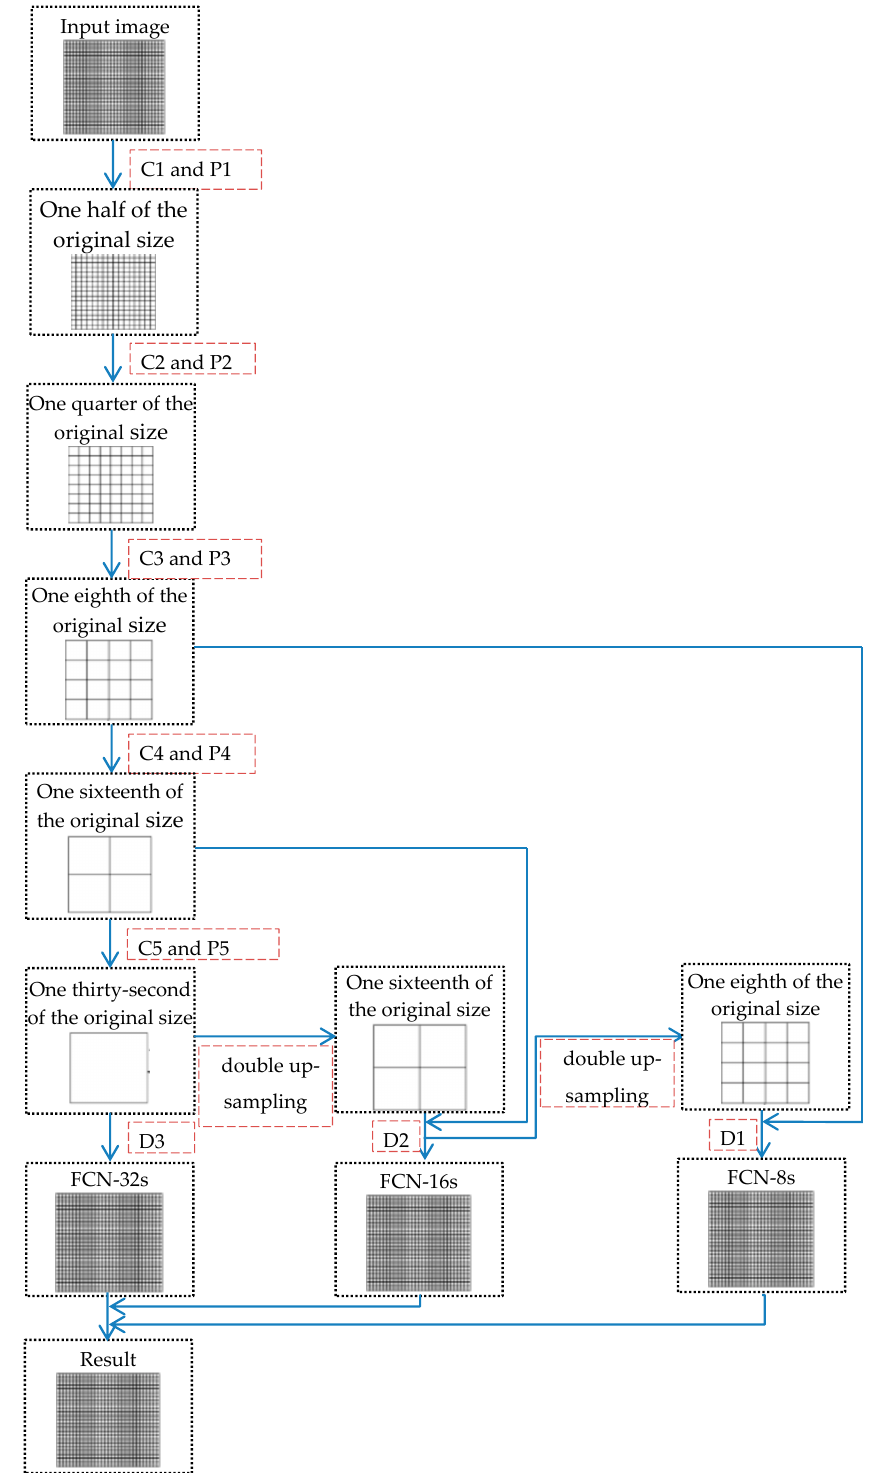
Figure 4. The training process of FCN.